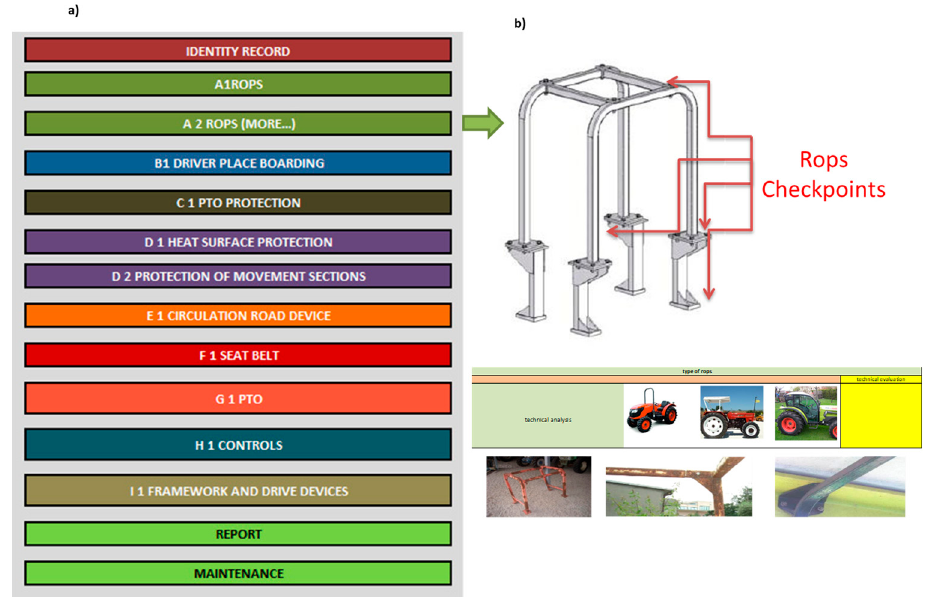
Figure 4. Extract from the software designed for the analysis of the tractors ( a ), ( b ) specific ROPS (rollover protection system) control areas.